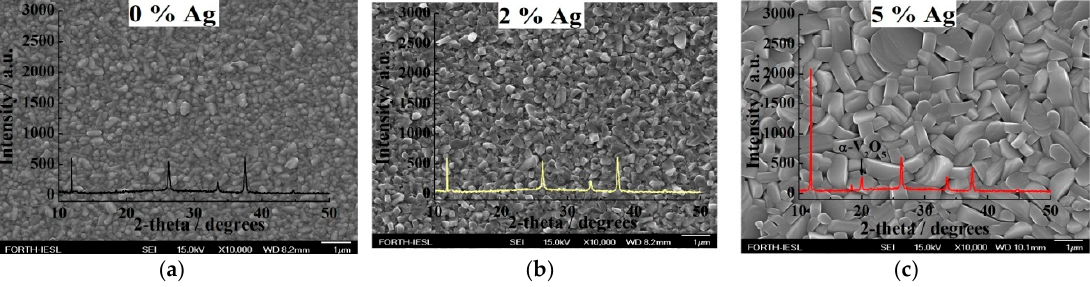
Figure 5. XRD patterns overlapped over FE-SEM images of the V 2 O 5 grown at 450 °C for 1 h via AACVD under atmospheric pressure for ( a ) 0% ( b ) 2%, and ( c ) 5% Ag loading and annealed at 600 °C for 3 h.